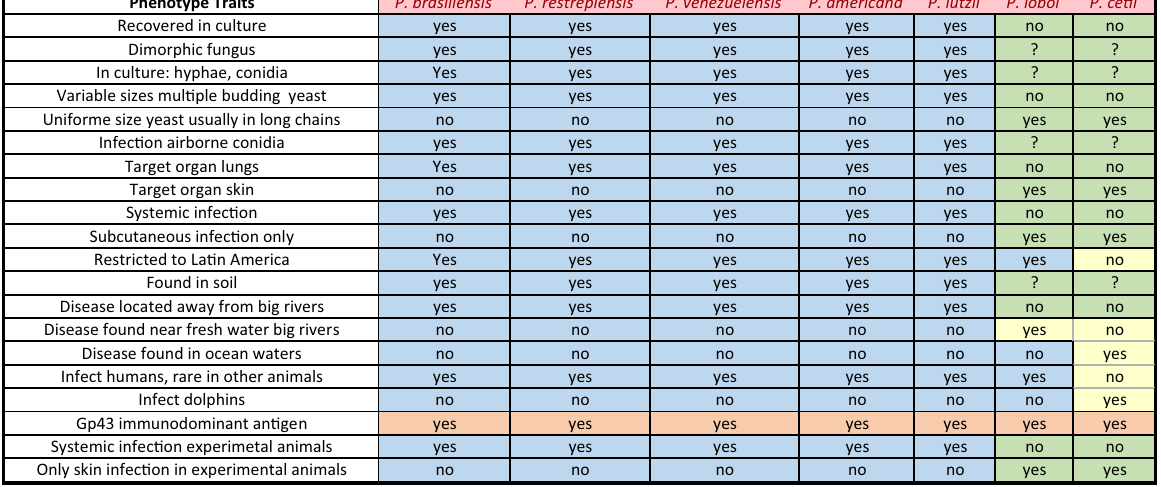
(Table S1) using three components (PC1, PC2 and PC3) grouped Paracoccidioides species into five populations corresponding to some of the above species (Fig. 2). The three principal components accounted for 71.0%, 12.6%, and 6.7%, respectively, with cumulative variation explaining 90.3% of the interrogated DNA sequences, indicating the relationship of individuals present in each cluster is reliable (Fig. 2). Paracoccidioides loboi (pink) and P. lutzii (yellow) were discriminated by PCA, placing them in independent clusters on the lower right sec- tion of Fig. 2. Paracoccidioides americana (green) and P. cetii (blue) DNA sequences were also discriminated into two clusters on the upper left section of the graphic (Fig. 2). The remaining species including P. brasiliensis , P. restrepiensis and P. venezuelensis (red) formed a single cluster located at the lower left section of the graphic.